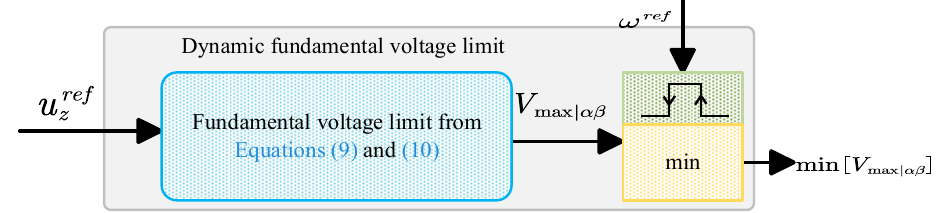
Figure 6. The process of dynamic fundamental voltage limit.